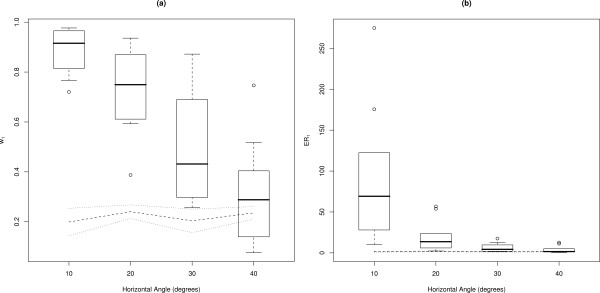
Effect of angles of yaw. Box-and-whisker plots of (a) IC weights (w1) for horizontal angle categories, where images at 0° were matched against images skewed by 10°, 20°, 30° and 40°. Dotted lines show results for non-matching pairs; (b) evidence ratios (ER1) for horizontal angle categories, where images at 0° were matched against images skewed by 10°, 20°, 30° and 40°. Central tendency (black horizontal line) indicates the median, and whiskers extend to 0.5 of the inter-quartile range.